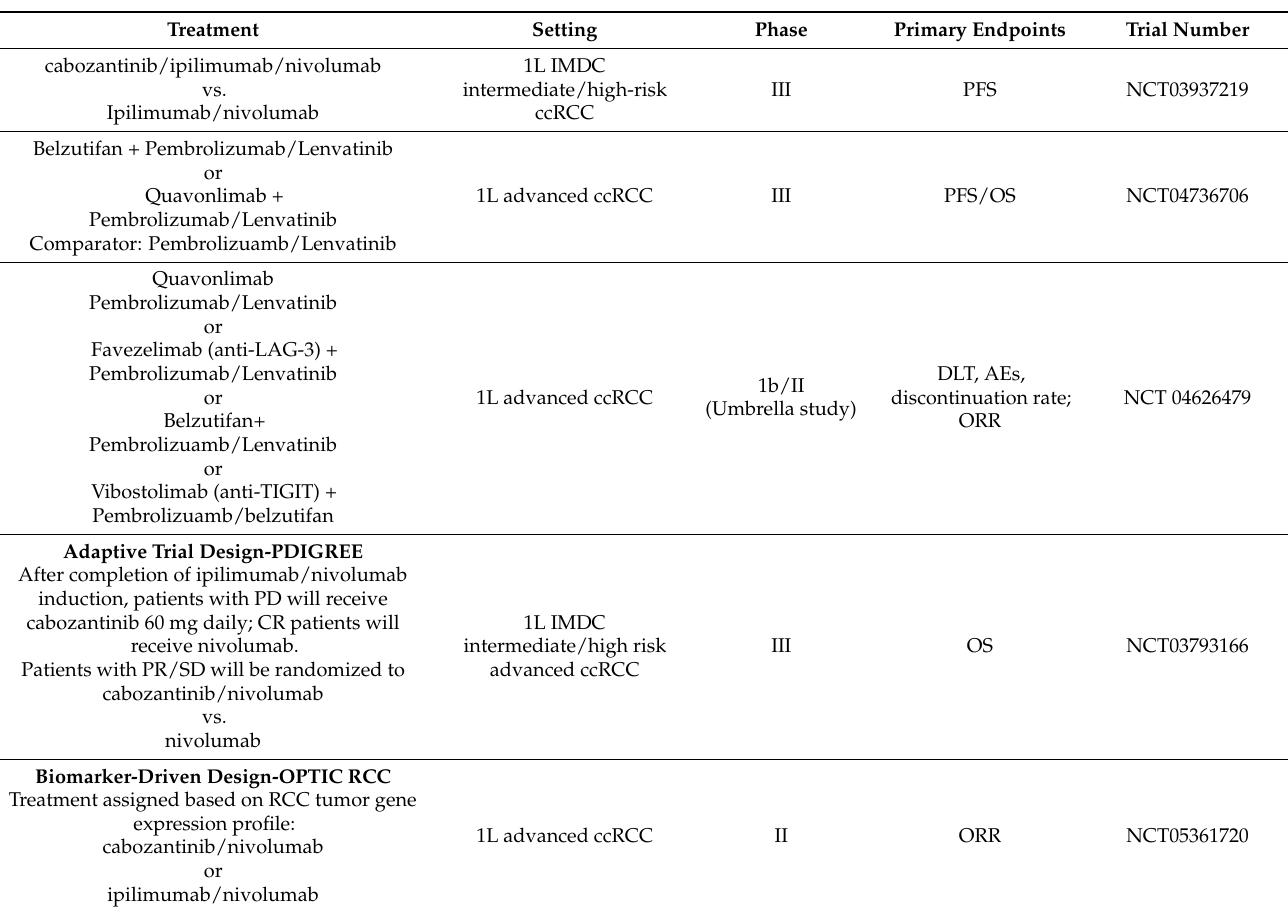
Table 4. Ongoing clinical trials using triplets or novel trial